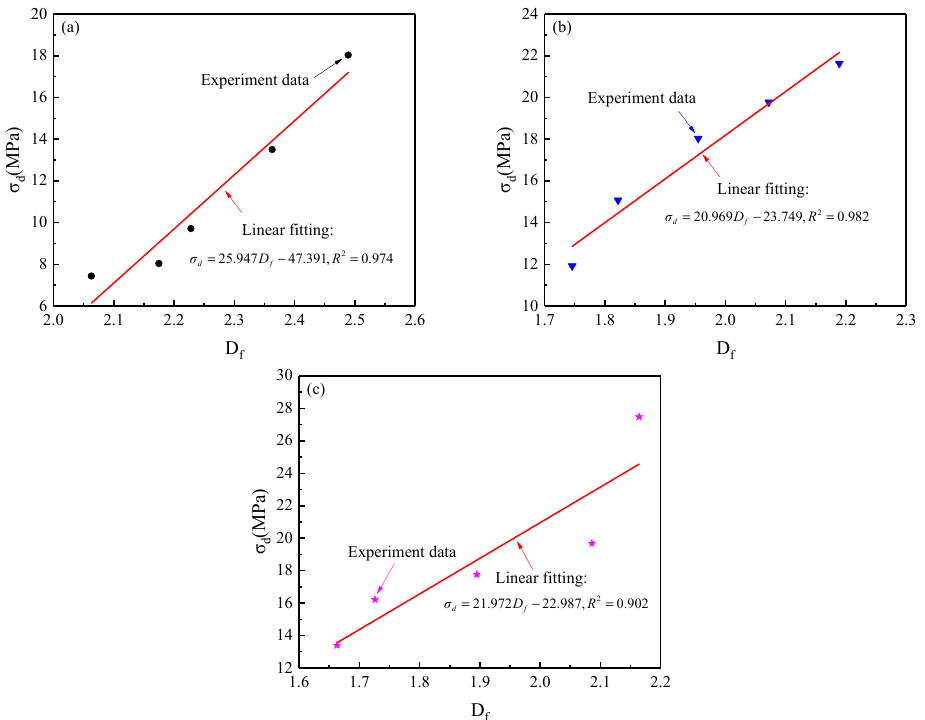
Figure 22. Relation between dynamic strength and fractal dimension: effect of strain rate. ( a ) T = 0.5; ( b ) T = 1.0; ( c ) T = 2.0.